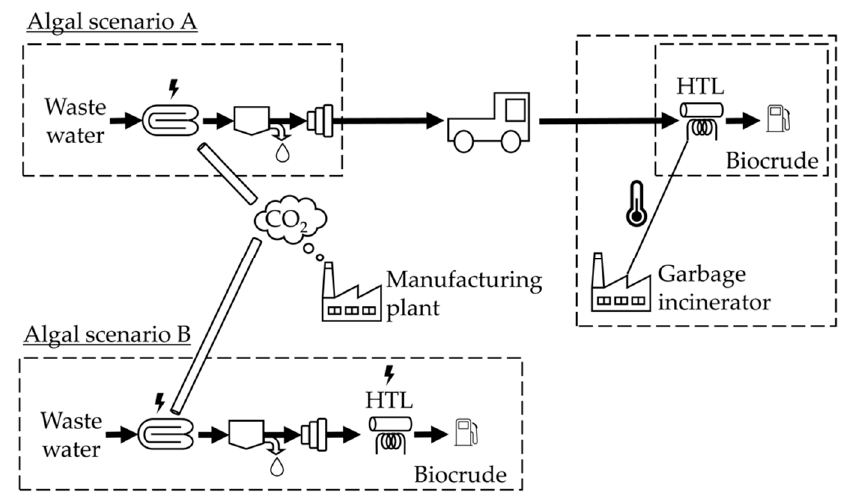
Figure 7. Comparison of algal scenarios A and B based on proximity of neighboring facilities.